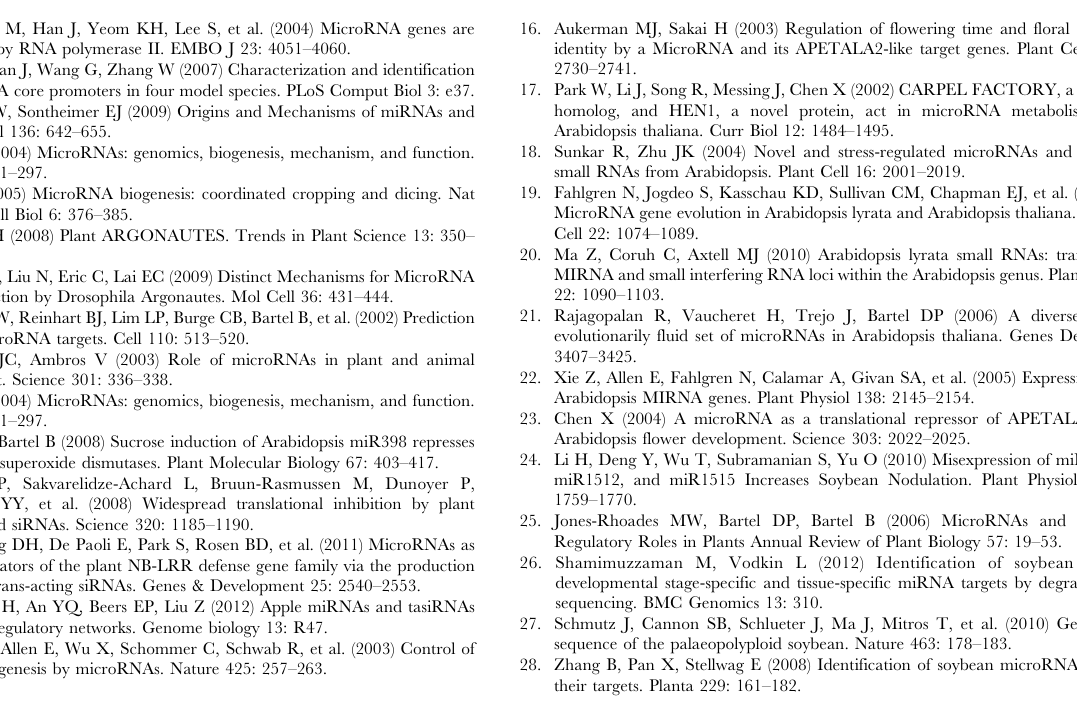
Table S12. Over- or Under-Representation of